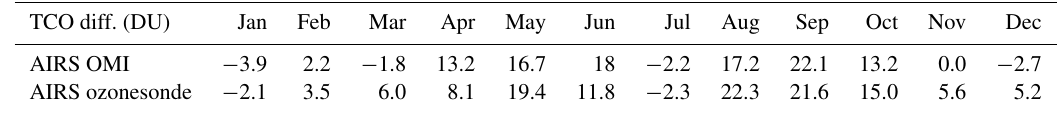
Table 3. Total column ozone (TCO) differences (in DU) between AIRS, OMI, and ozonesonde during 12 months. TCO diff. (DU) Jan Feb Mar Apr May Jun AIRS